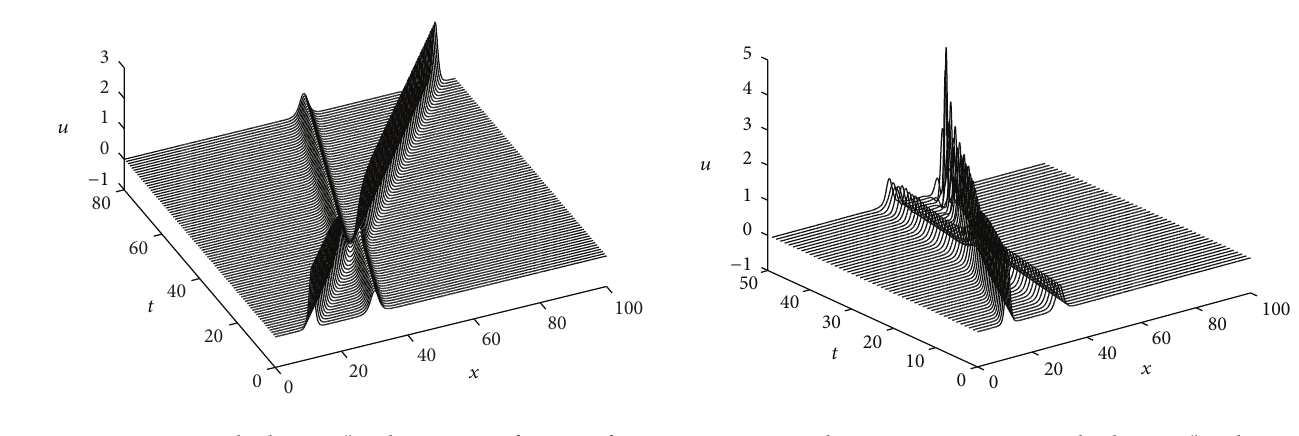
Figure 3: Numerical solution 𝑈 𝑛 with parameters 𝜆 1 = 1.0 , 𝜆 2 = = 10 , and 𝑦 = 30 . 0.6 , 𝑦 1 2